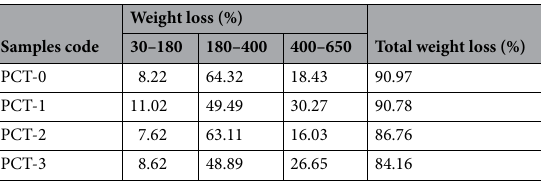
Table 3. Weight loss at different temperature on PVA/CMC/TUR films.